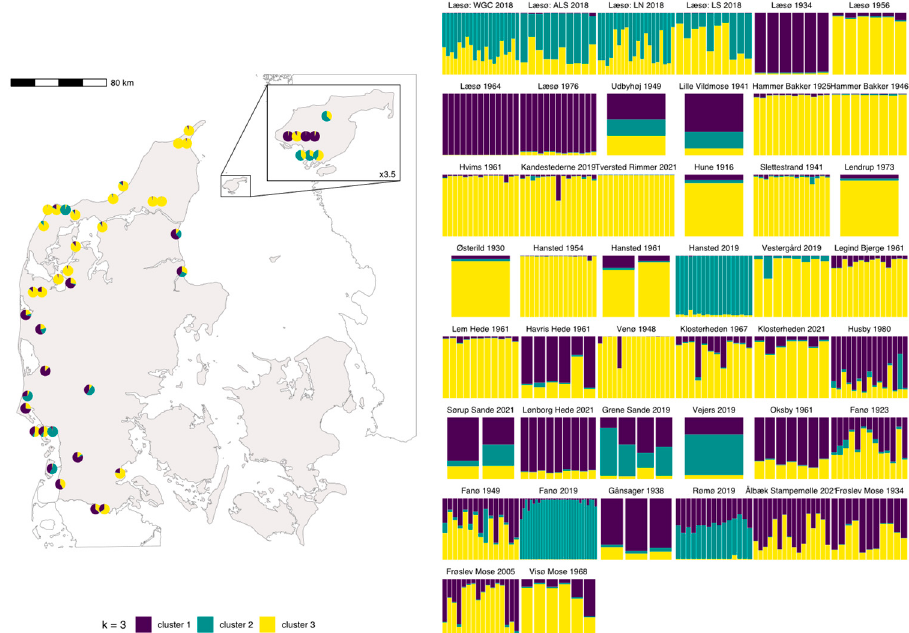
Figure 4. Results of genetic clustering analysis of the combined dataset in Structure for k = 3. The dataset included four loci. The bar plots show an individual’s probability of belonging to each of the three clusters and the pie charts on the map show the means of all individuals of each population. Populations placed on a row on the map show the separate points in time at which they were sampled, except for Læsø, where the bottom row shows the localities ALS, LN, and LS, which were in proximity to each other.